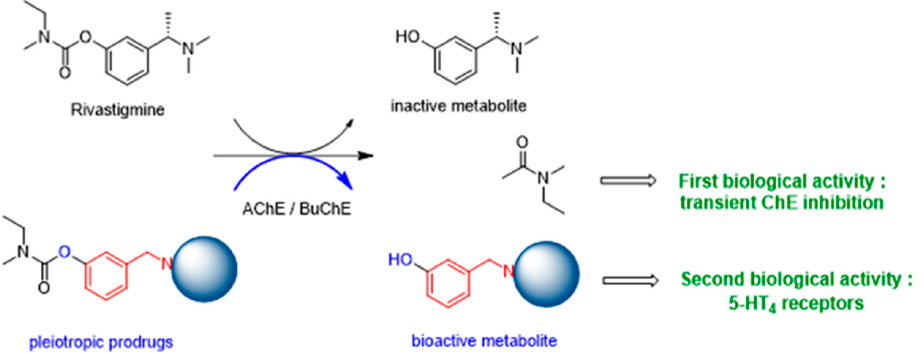
Figure 20. Mechanism of Action of rivastigmine and pleiotropic prodrugs.